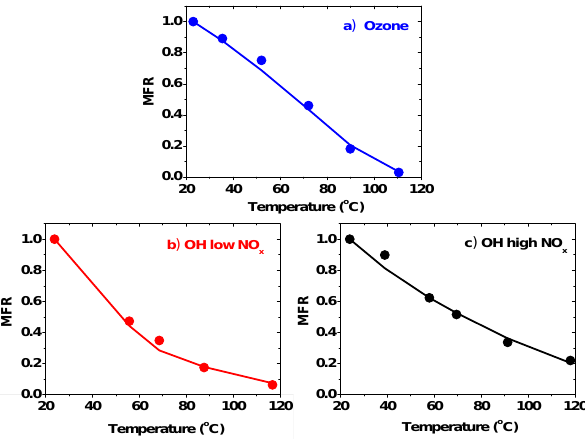
Figure 7. The measured aerosol mass concentration in the chamber as a function of time and the wall-loss-corrected SOA mass concen- tration (for w = 1) (Experiment 35). The shaded part indicates the period when the UV light was off, and the other section represents the period when the UV light was on. Also shown is the time when HONO was injected into the chamber.